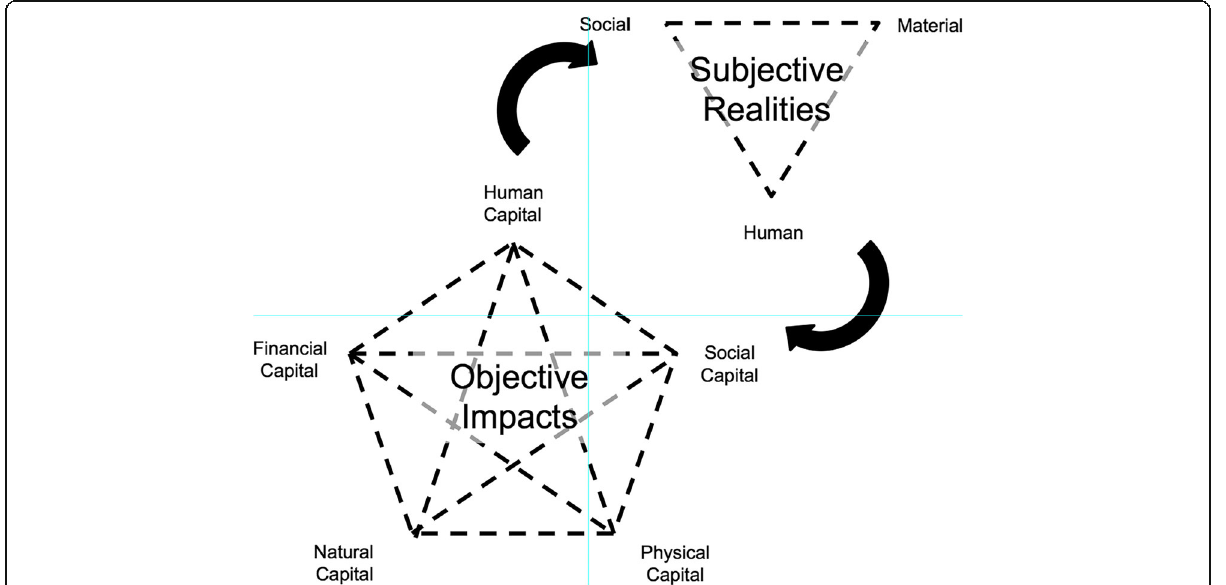
Figure 1 Measuring human impacts - the objective and the